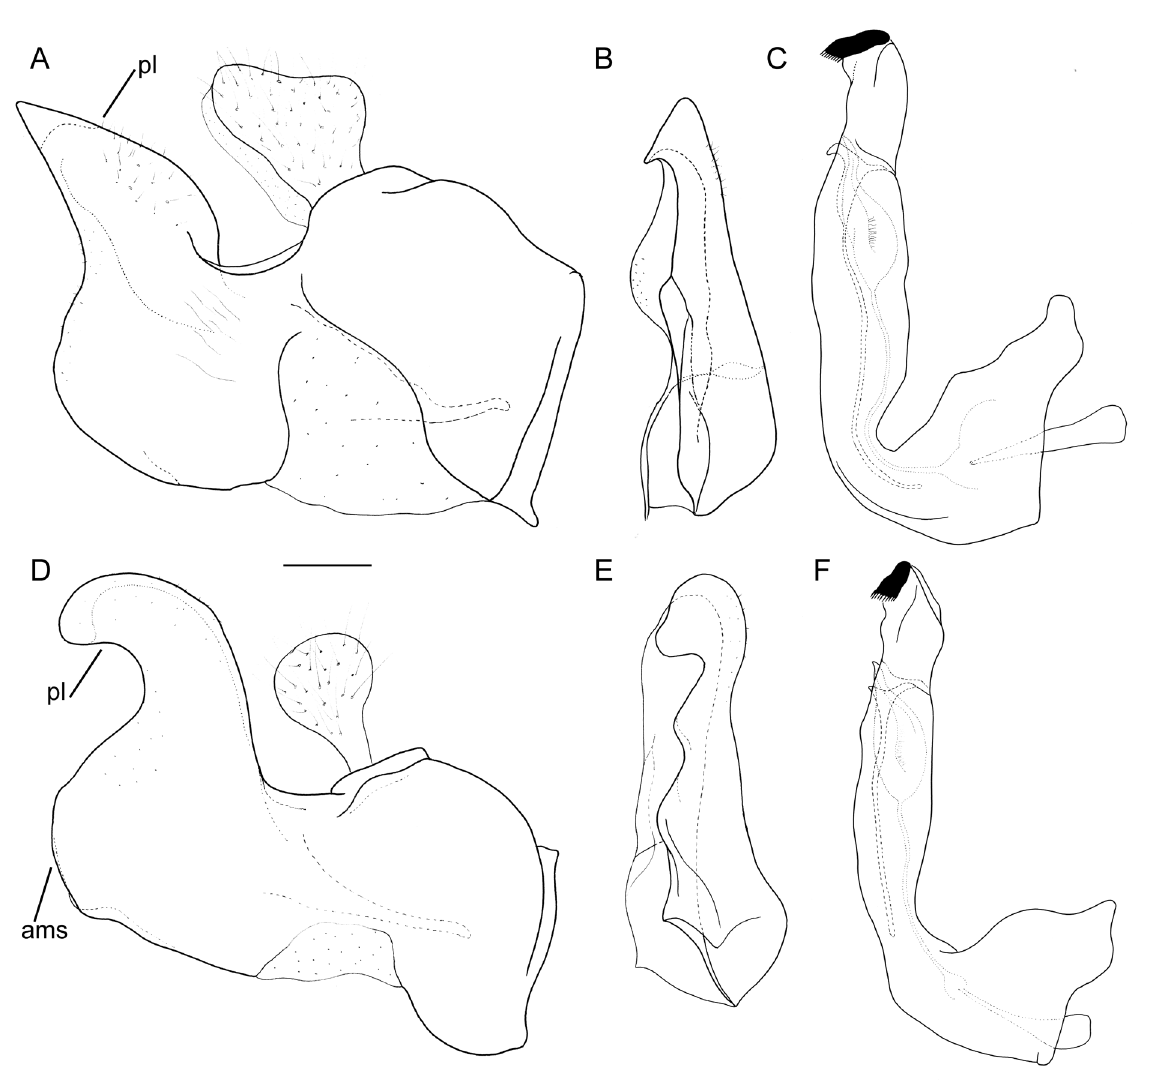
Fig. 19. Male genitalia. A–C . Merodon funestus (Fabricius, 1794) (FSUNS; FSUNS ID F99). D–F . M. nasicus Bezzi, 1915 (TAUI; FSUNS ID 04792). A, D . Epandrium, lateral view. B, E . Epandrium, ventral view. C, F . Hypandrium, lateral view. Abbreviations: ams = anterior margin of surstyle; pl = posterior lobe of surstyle. Scale bar = 0.25